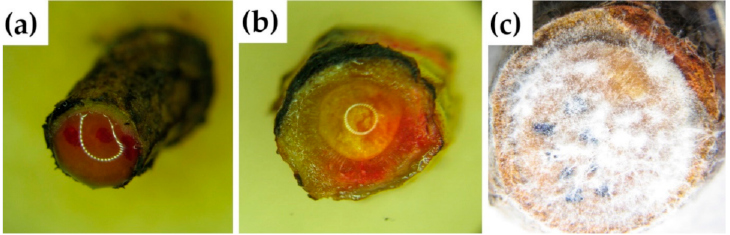
Figure 2. ( a , b ) Stem discs of MeJA-treated P. sylvestris ramets with resin on their surface; ( c ) Stem disc of a control ramet with Heterobasidion spp.